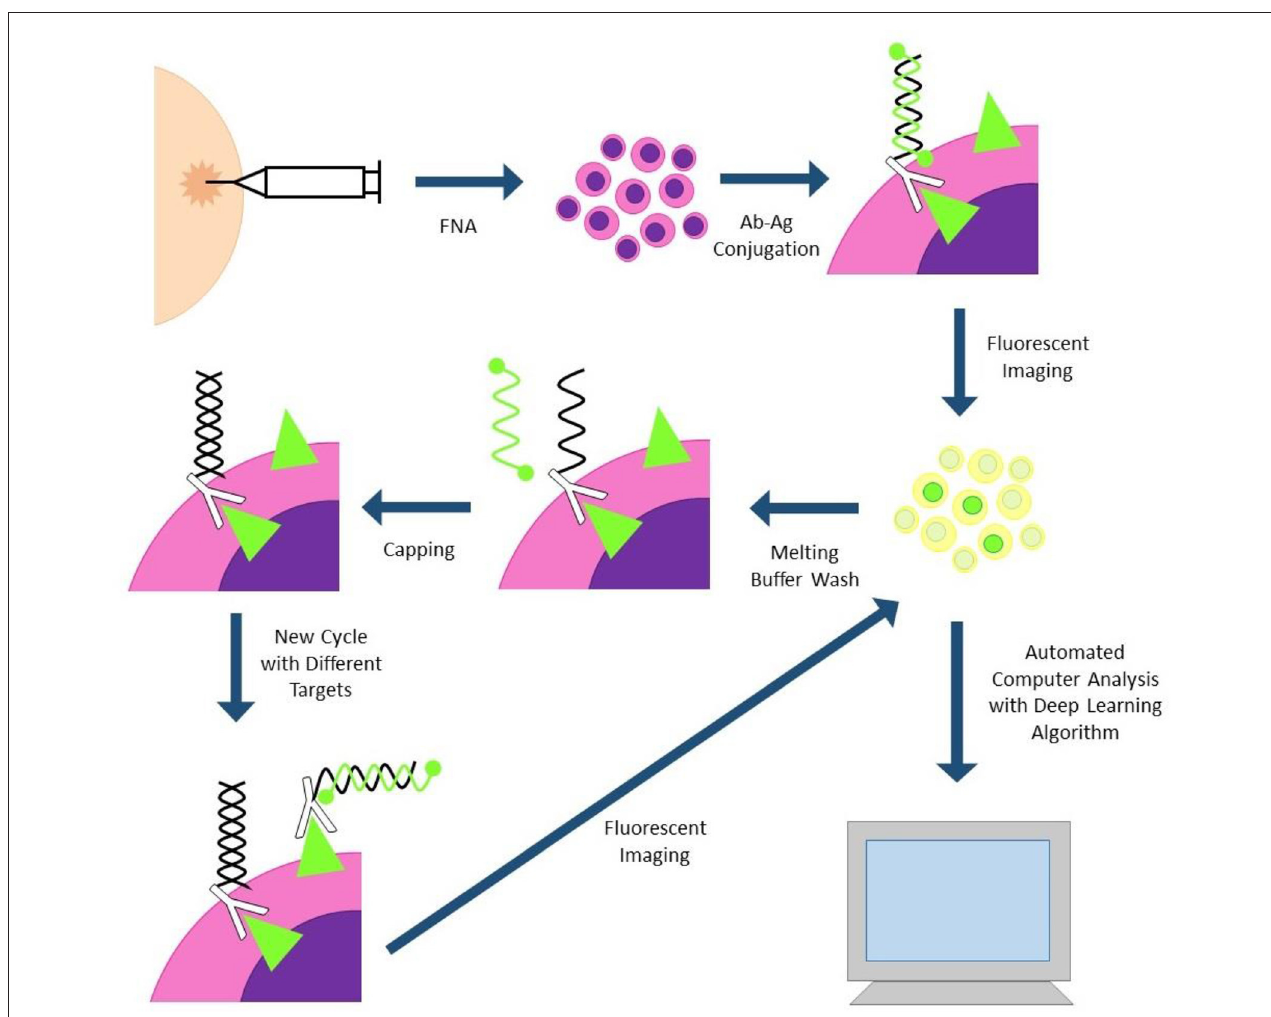
FIGURE 2 | SCANT (single cell analysis for tumor phenotyping). Cells are obtained via fine needle aspiration biopsy and incubated with DNA-antibody conjugates. DNA strands are hybridized to complementary strands with two flurochromes; antibodies with different flurochromes will fluoresce at different channels. Cells are imaged and subjected to automated image analysis. Fluorescent strands can be washed off and capped between cycles to reduce cycle-to-cycle